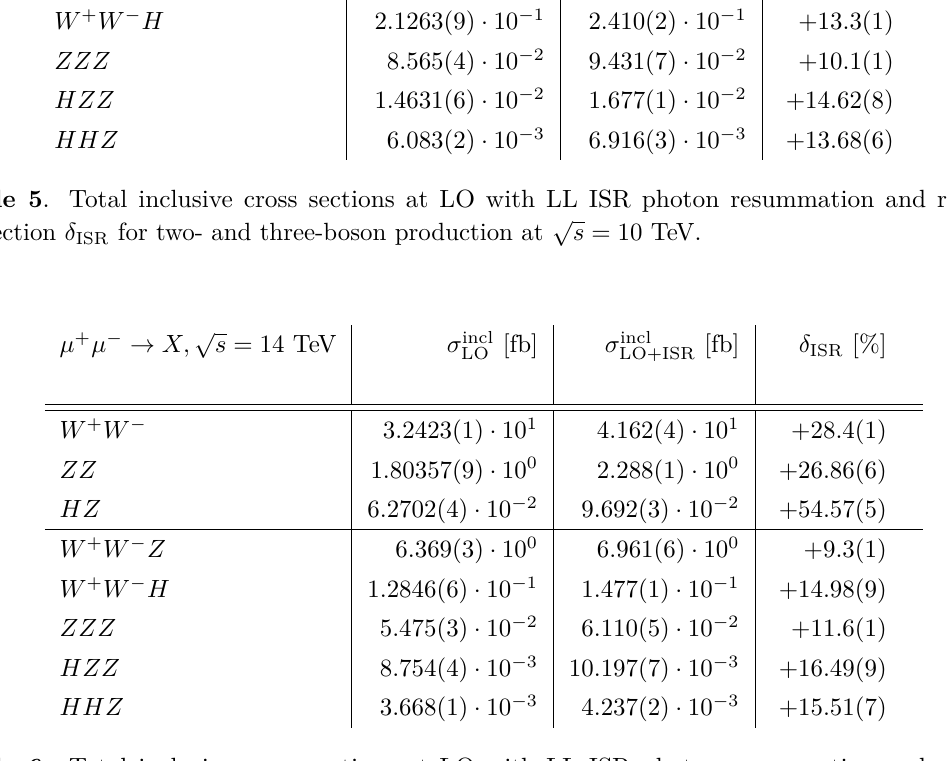
Table 6 . Total inclusive cross sections at LO with LL ISR photon resummation and relative correction δ ISR for two- and three-boson production at